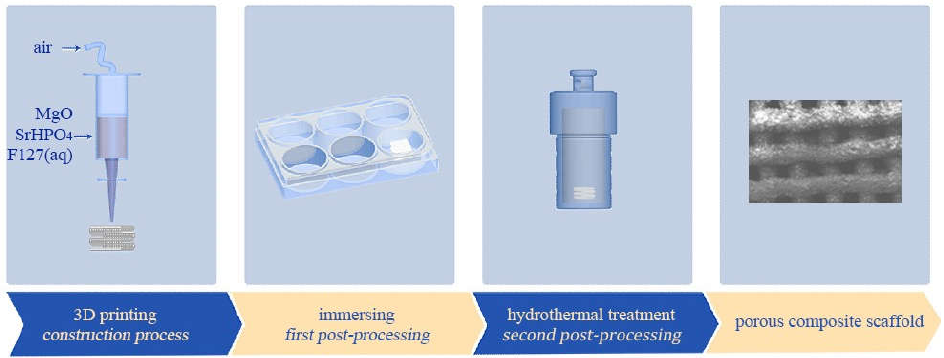
Figure 1. Schematic diagrams of manufacturing process of the MgNH 4 PO 4 ·H 2 O/SrHPO 4 porous composite scaffolds.